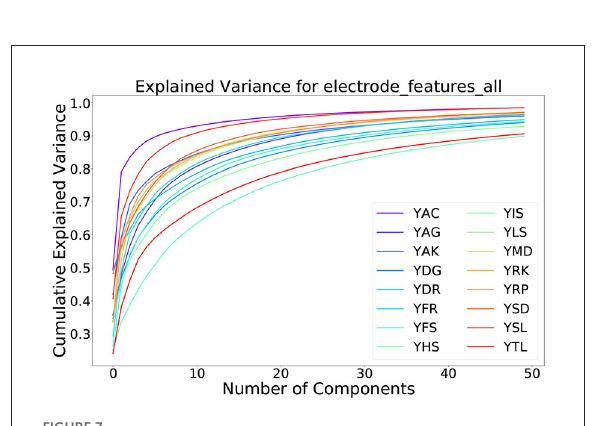
FIGURE7 Variance explained with increasing number of PCA components for the training subjects in ZuCo 2.0.